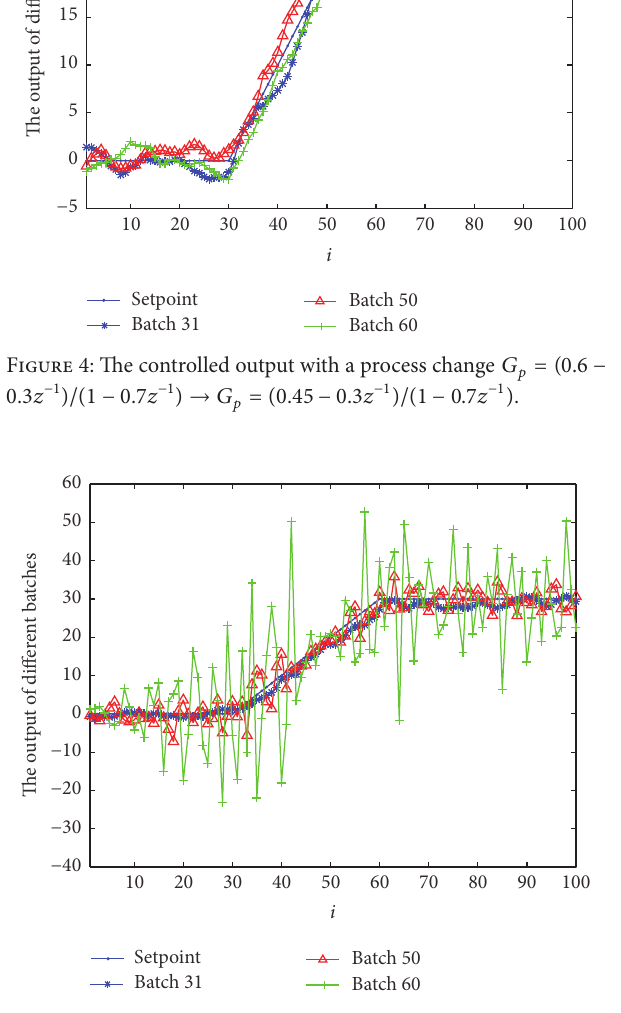
Figure 5: The controlled output with a process change 𝐺 𝑝 = (0.6 − = (0.6𝑧 −1 − 0.3𝑧 −2 )/(1 − 0.7𝑧 −1 ) . 0.3𝑧 −1 )/(1 − 0.7𝑧 −1 ) → 𝐺 𝑝